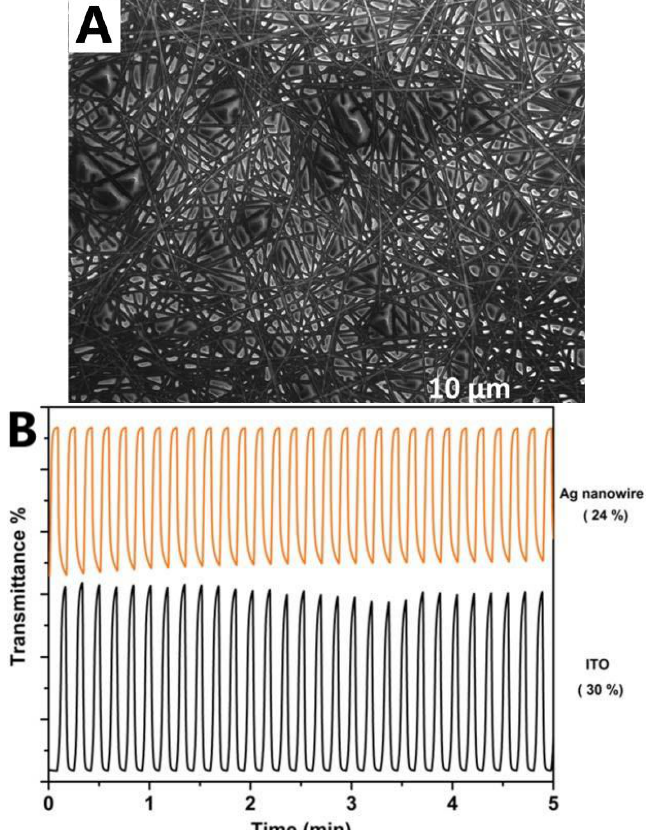
Figure 20. ( A ) SEM image of Ag / NW / P1C nanocomposite electrodes and ( B ) cyclic voltammetry (CV) study of P1C on AgNW-network-deposited PET substrates [91].